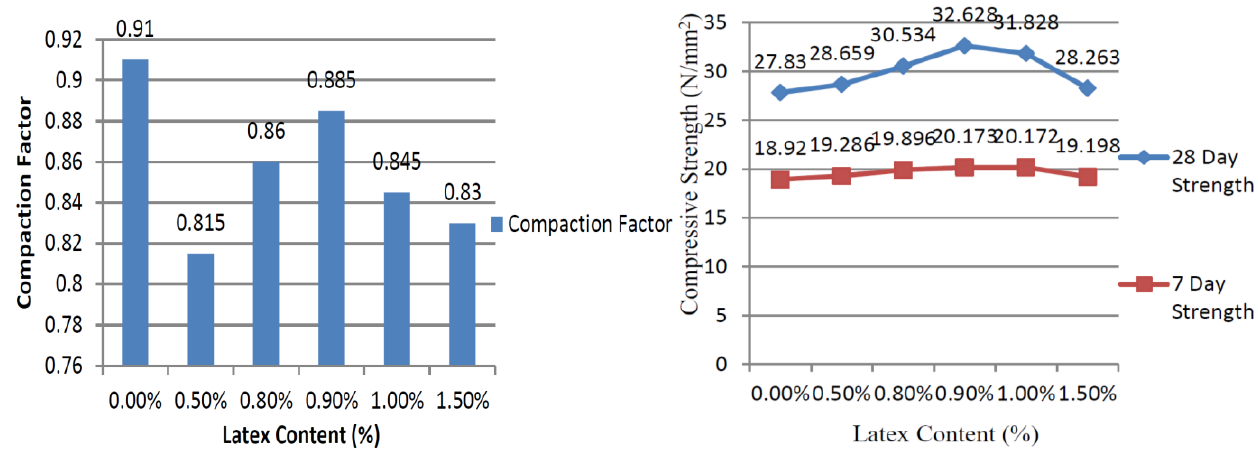
Figure 12. The Flow Chart of The Proposed Model. Test results showed that natural rubber latex affects concrete properties (Paul Shaji et al